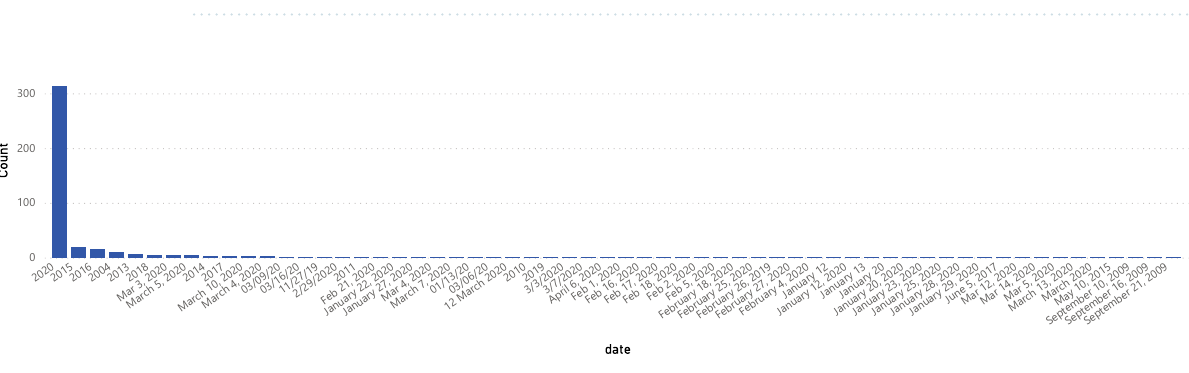
Figure 3. Cohen dataset metadata related to the date of the study (showing inconsistency on this data label).